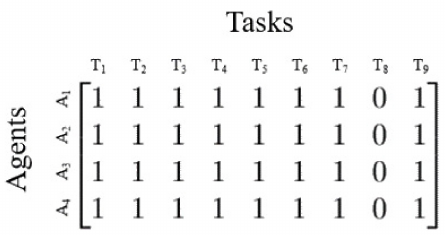
Figure 20. Potential Capability Matrix (PCM) for the example.